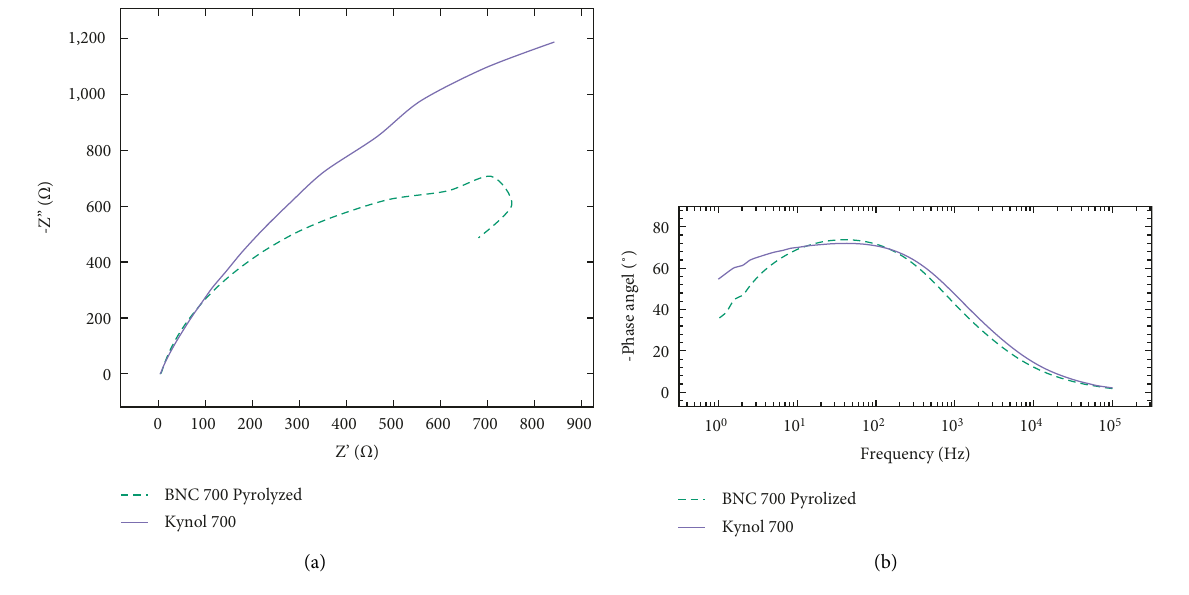
Figure 9: In (a) Nyquist plot and in (b) Bode plot (100kHz—1 Hz). Table 3: Specific capacitance at 5mV/s compared to the specific surface area.